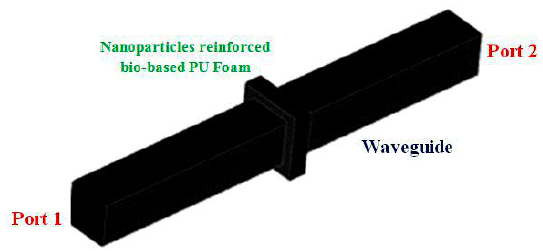
Figure 9. 3-D model for analyzing electric field intensity.